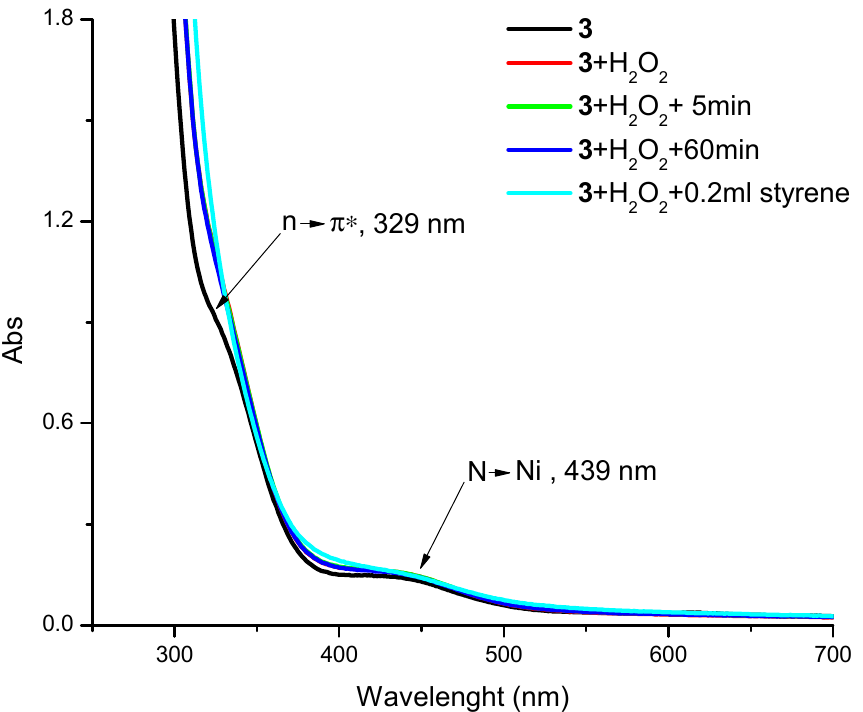
Figure 10. UV-visible analysis of the oxidation of styrene catalyzed by complex 3 , using H 2 O 2 as the oxidant.